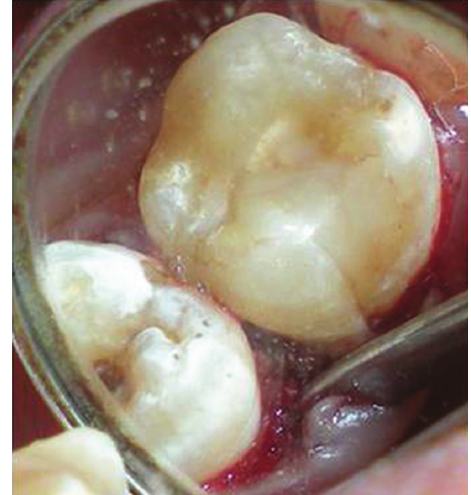
Figure 20: Occlusal view of fractured distofacial fragment posi- tioned at its original site with respect to 16. Build up of lost mesiopalatal fragment is done with microhybrid